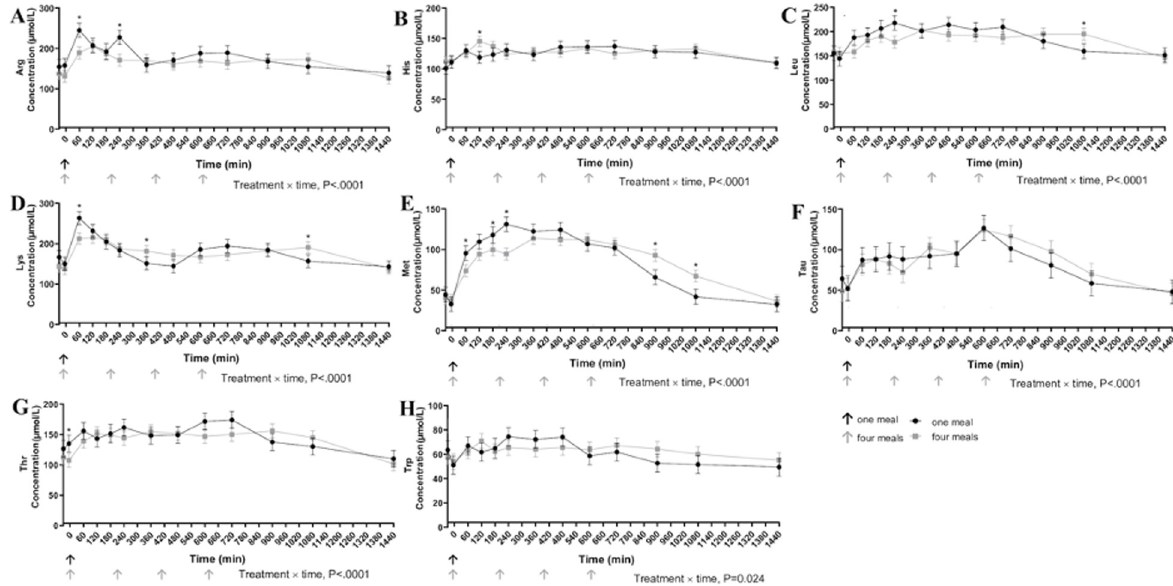
Fig 3. Plasma concentration ( μ mol/L) of arginine (A), histidine (B), leucine (C), lysine (D), methionine (E), taurine (F), threonine (G), and tryptophan (H) in cats eating a canned diet once (0800h) or four (0800h, 1130h, 1500h, 1830h) times daily over 24 hours (n = 8 but with 11 experimental periods). Values are expressed as LSM ± SEM. � = P < 0.05.